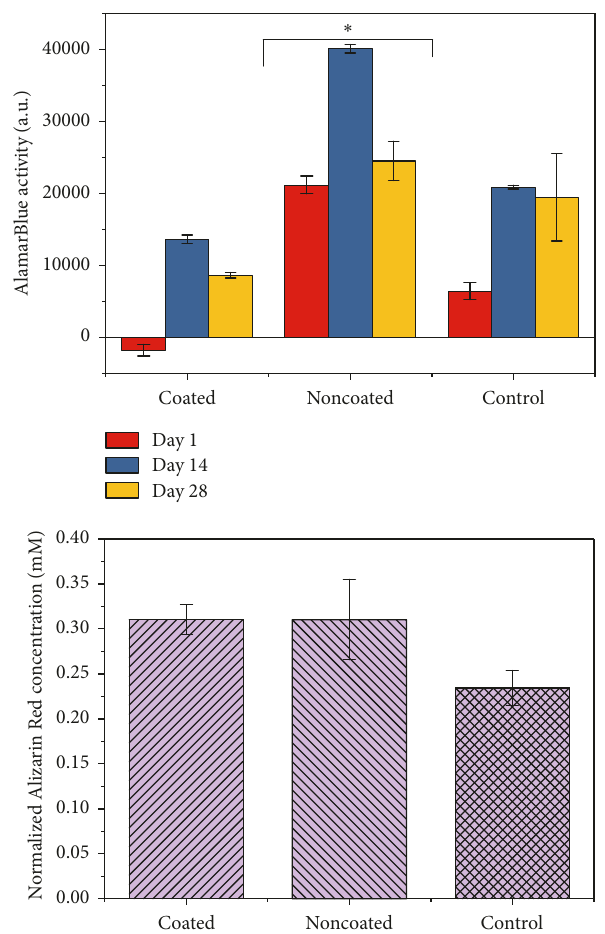
Figure 3: Biocompatibility and osteoinductivity of porous Ti scaffolds. AlamarBlue absorbance of BMMSCs seeded on HAp coated noncoated scaffolds over 28 days; Alizarin Red absorbance normalized to noncoated samples at day 28. ∗ shows significantly higher value compared to other samples ( 𝑝 < 0.05